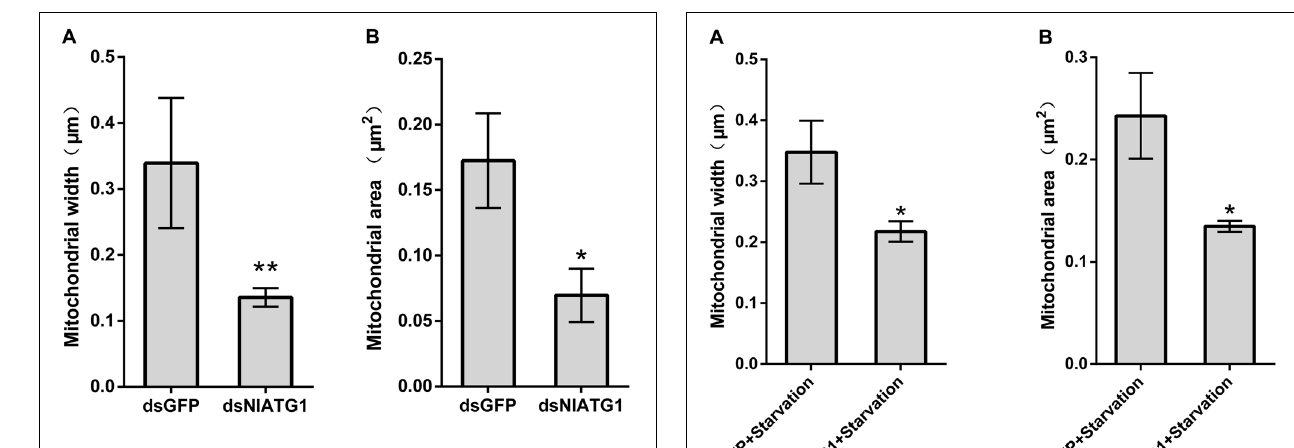
FIGURE 6 | Mitochondrial width and mitochondrial area when treated with dsRNA. (A) mitochondrial width; (B) mitochondrial area. All values are presented as the mean ± SD of three independent biological replicates (* p < 0.05, ** p < 0.01). (Approximately 100 mitochondria were measured per replicate). FIGURE 7 | Mitochondrial width and mitochondrial area when treated with